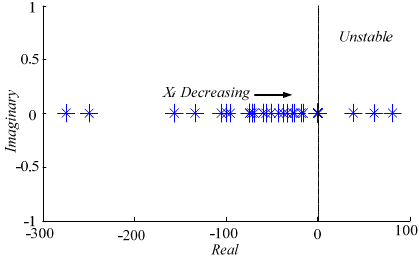
Figure 7. Root locus by decreasing the line coupling inductance.